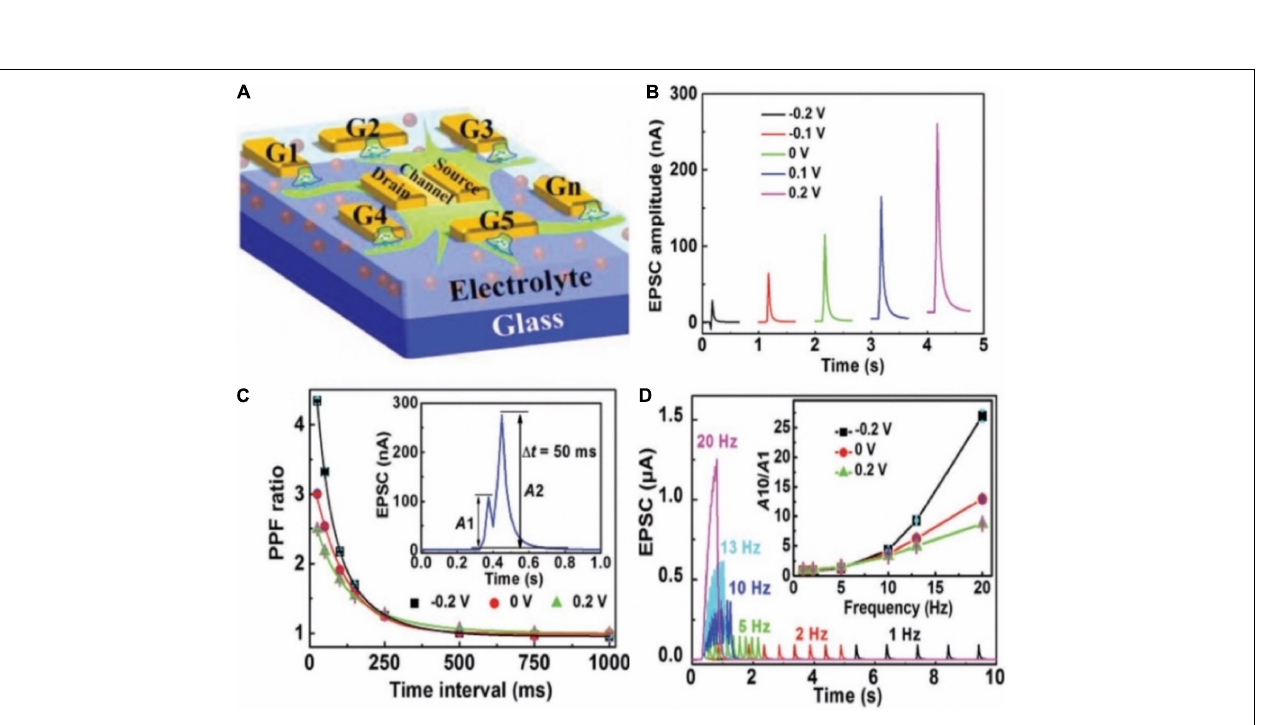
Frontiers in Neuroscience |